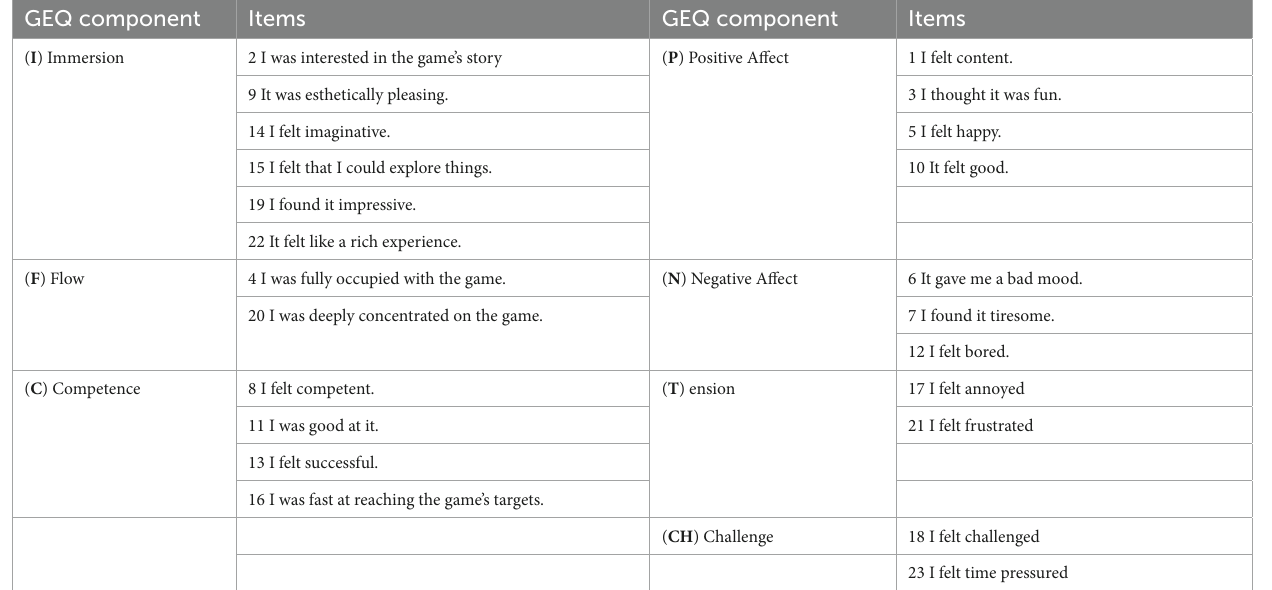
TABLE 2 Mapping of GEQ items to the player experience components. GEQ